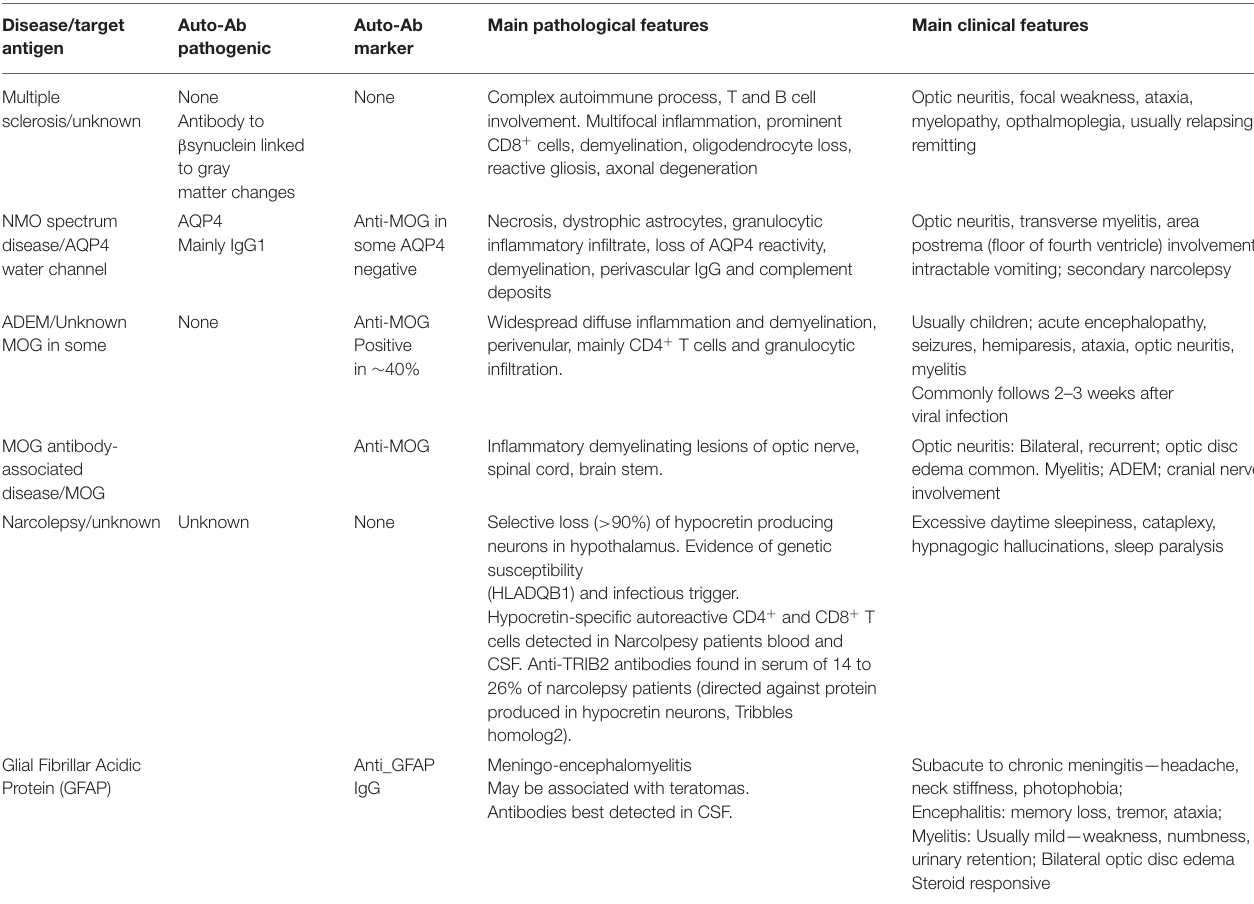
TABLE 2 | Classic and new CNS autoimmune